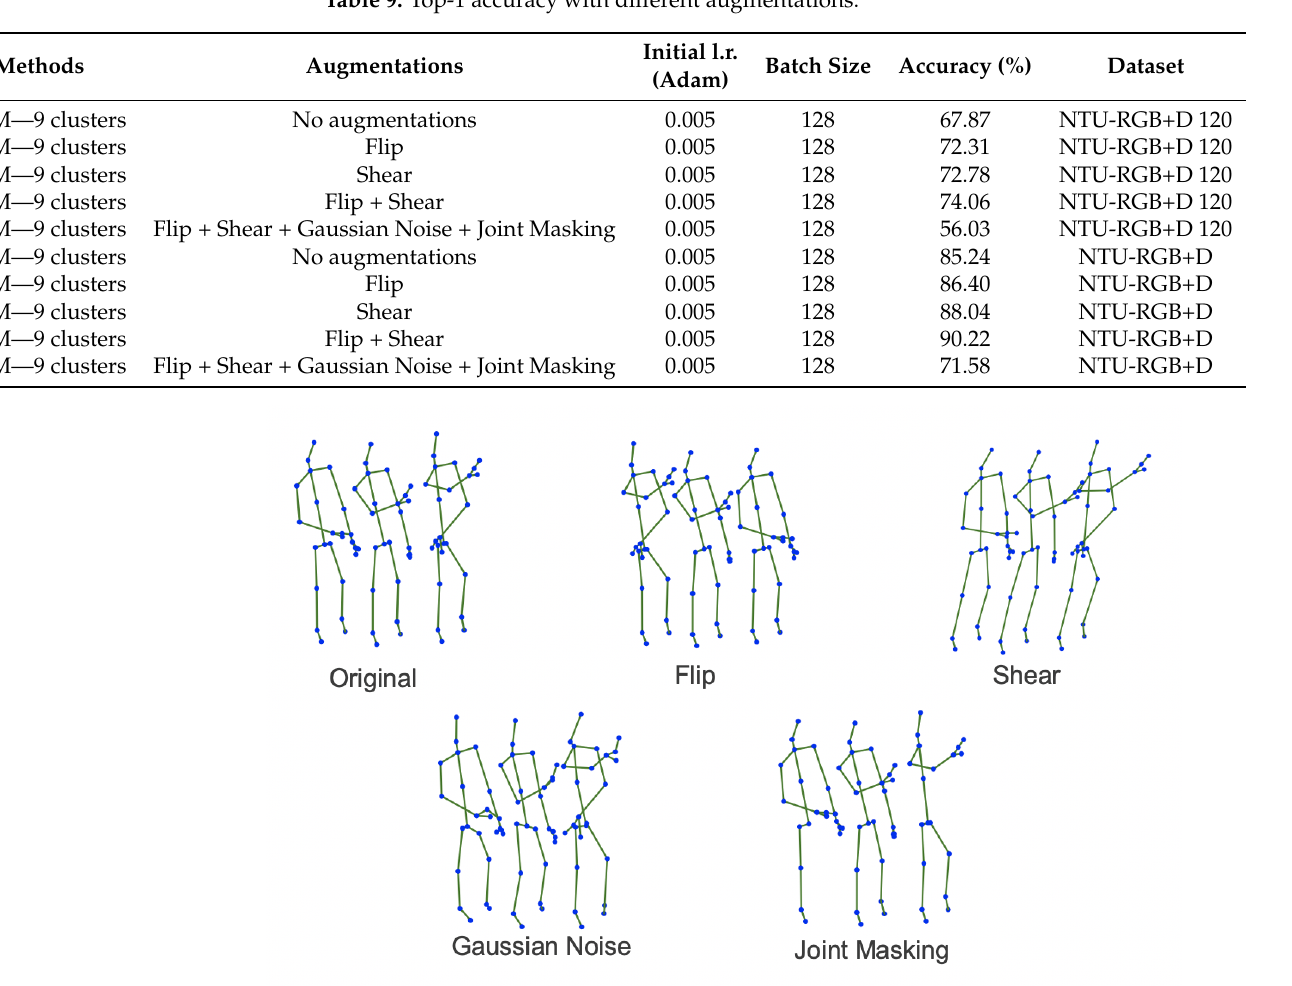
Table 9. Top-1 accuracy with different augmentations.